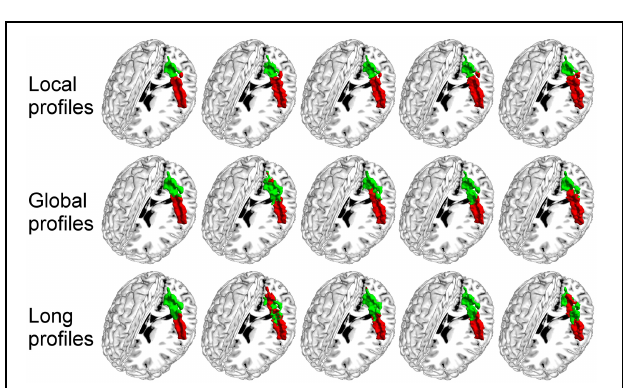
FIGURE 4 | The primary motor cortex (M1) in the left hemisphere was parcellated into two subregions using local, global, and long connectivity profiles. The MPM from dataset 1 of the M1 (first column) and 4 individual example results using local, global, and long connectivity profiles are shown.